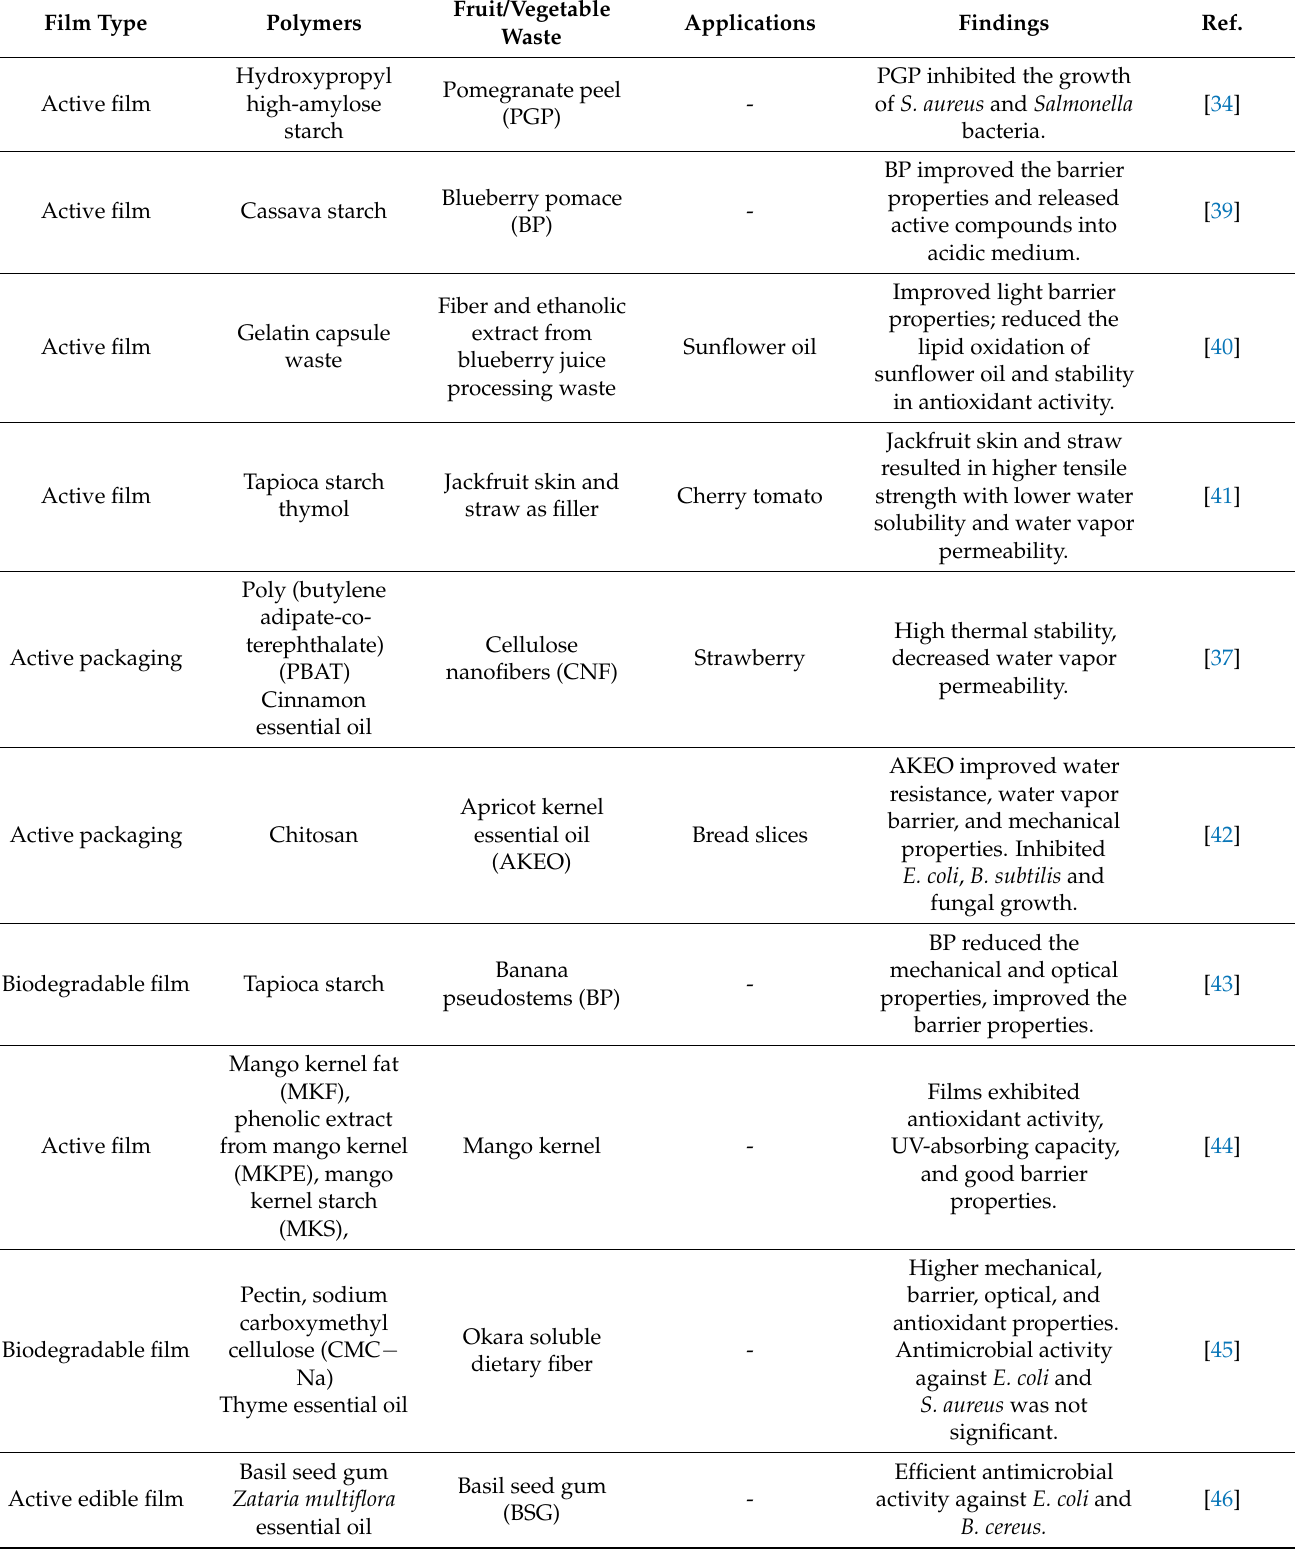
Table 1. Utilization of fruit and vegetable wastes in food packaging